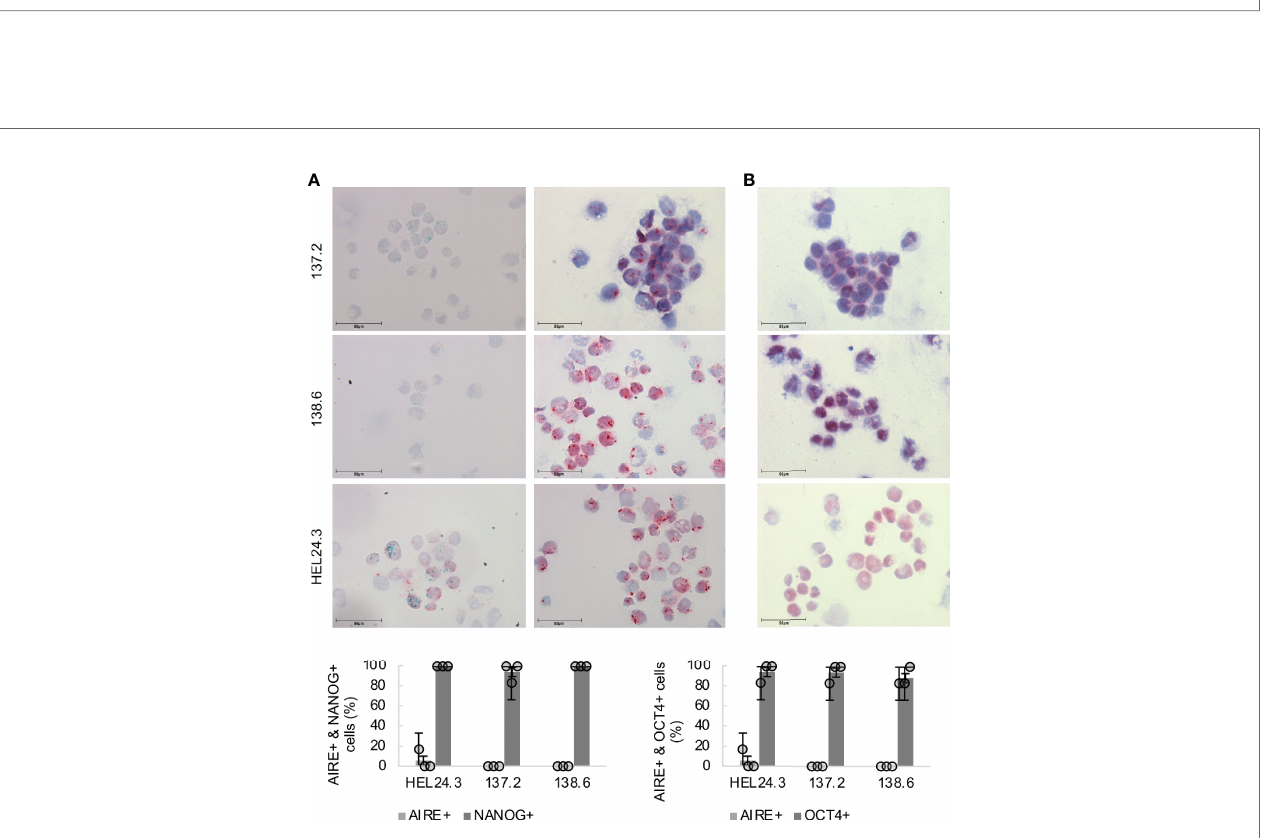
FIGURE 3 | Subcellular localization of AIRE and stemness-associated proteins does not differ in APECED patient -derived iPSCs compared to healthy person- derived iPS cells. Top panel (A) : AIRE (green) and NANOG (red) expression in iPSCs, (B) : OCT4 (red) in iPSCs. Mayer ’ s hematoxylin (blue) used as nuclear counterstain. Bottom graph: Quantitation of AIRE+, NANOG+ and OCT4+ in healthy control iPSCs HEL24.3 and APECED iPSCs 137.2 and 138.6. Circles represent three individually performed replicates, with error bars representing SD within a replicate. The bar graphs represent the mean of the three replicates, with error bars representing SEM of the replicates. No statistically signi fi cant difference was observed between the cell lines (p >